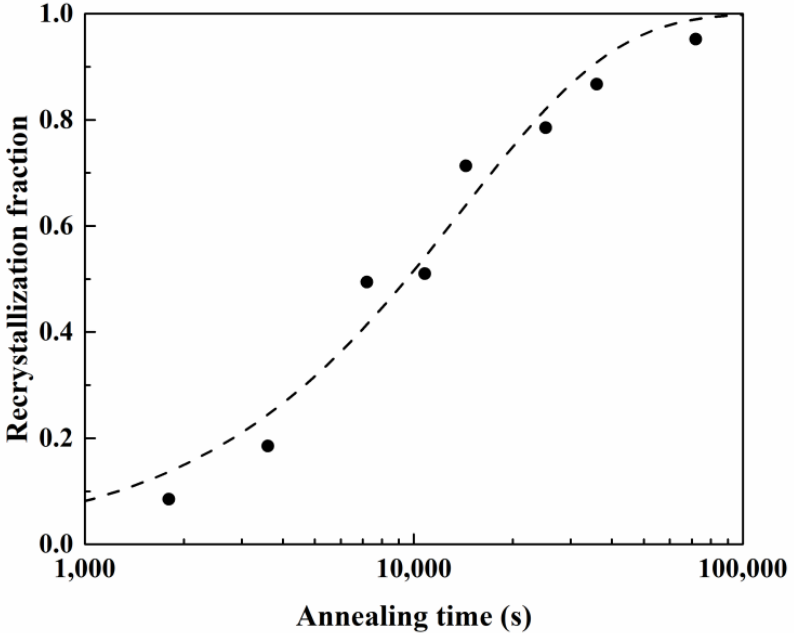
Figure 5. Recrystallization fraction of deep drawn AA5151 alloy to the annealing time calculated from experiment results, where the dashed line is predicted by using the JMAK equation.